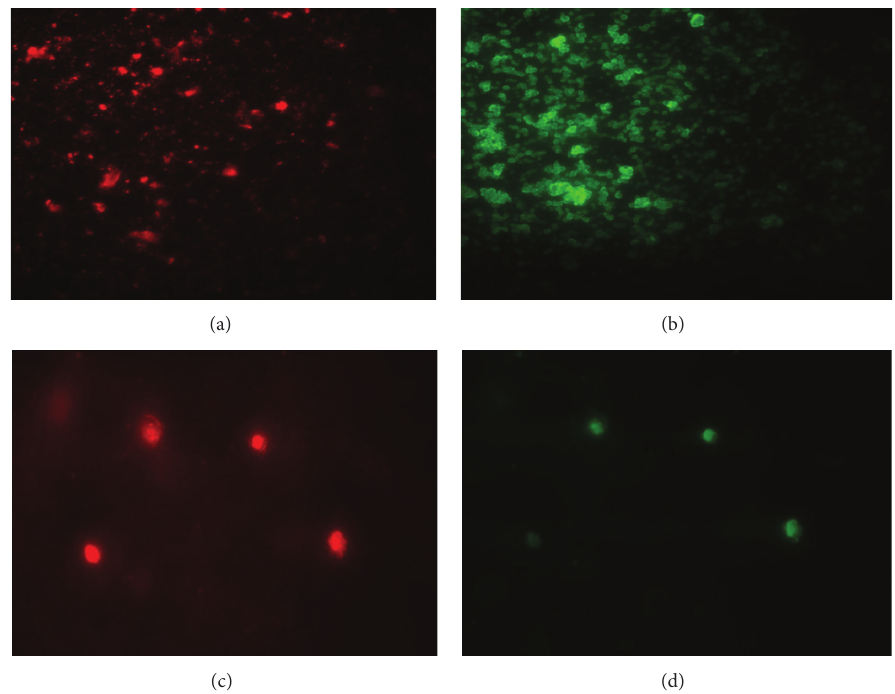
Figure 7: Fluorescence image of (a) CdS nanoparticles and (b) ZnS nanoparticles synthesized from K. pneumoniae.